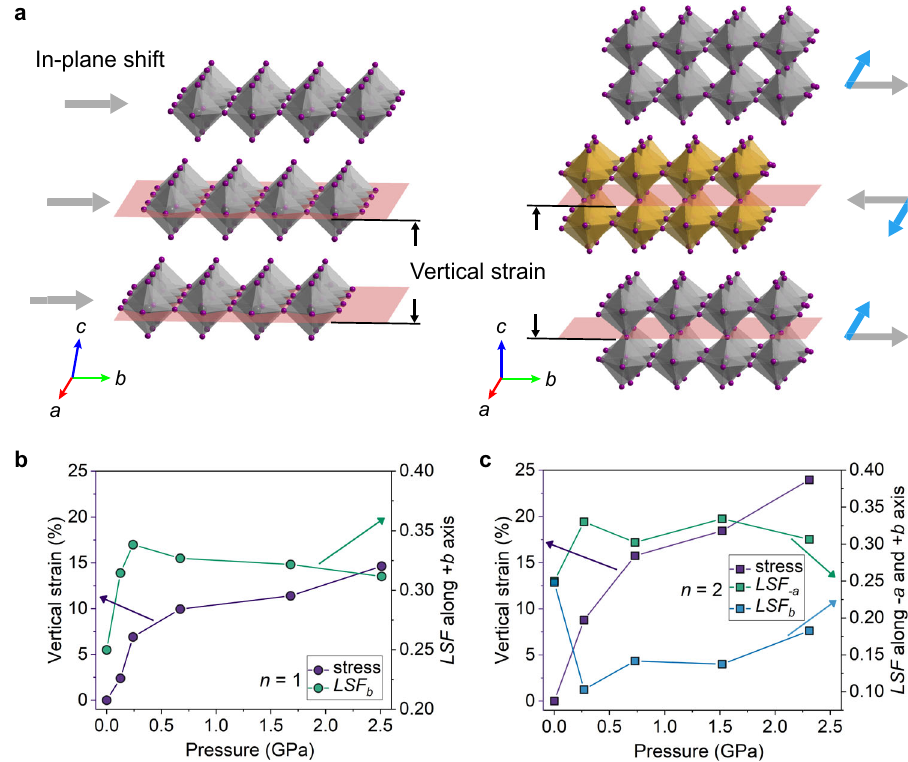
Fig. 2 | Distinctive pressure responses of n =1 and n =2 RPP. a Two generic types of layer-shift mode: Γ 5 + for n =1 and M 5 - ( a , b ) for n =2 RPP. b , c Pressure-dependent in-plane layer shift factor ( LSF ) and vertical strain for n =1 and 2 RPPs. Source data are provided as a Source Data fi